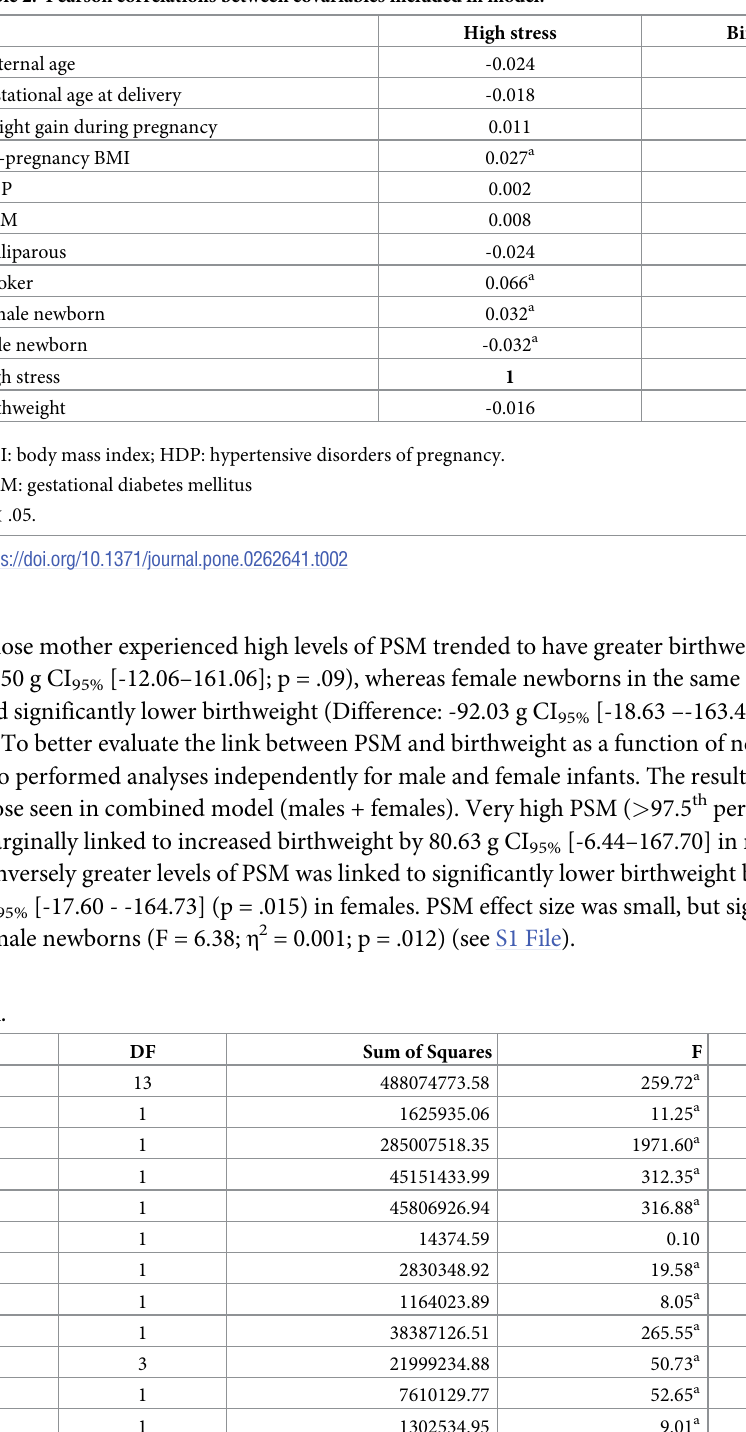
Table 2. Pearson correlations between covariables included in model.